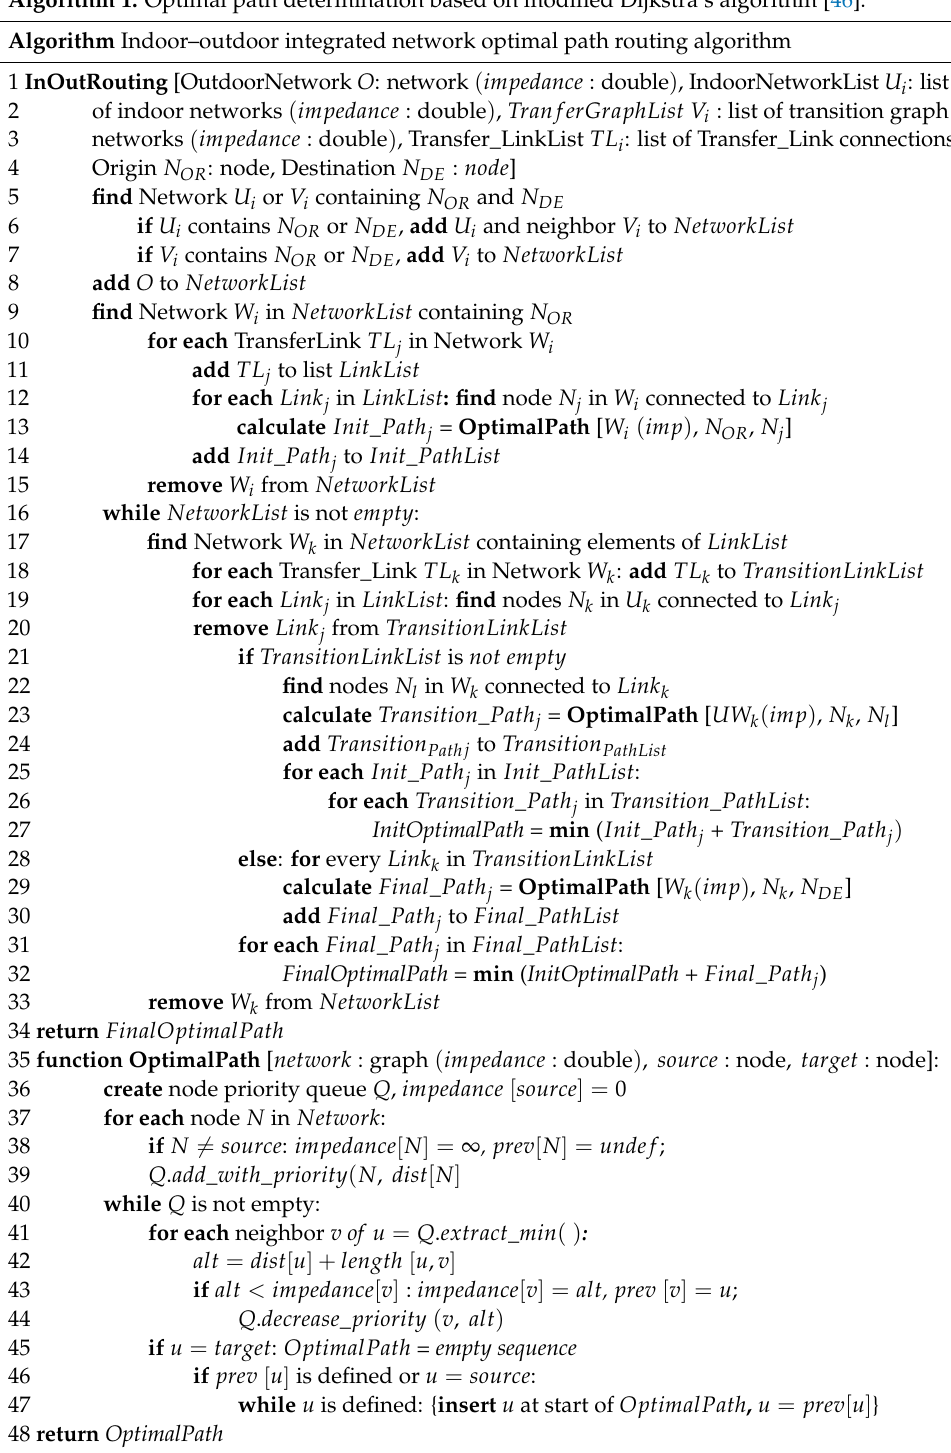
Algorithm 1. Optimal path determination based on modified Dijkstra’s algorithm [46]. Algorithm Indoor–outdoor integrated network optimal path routing